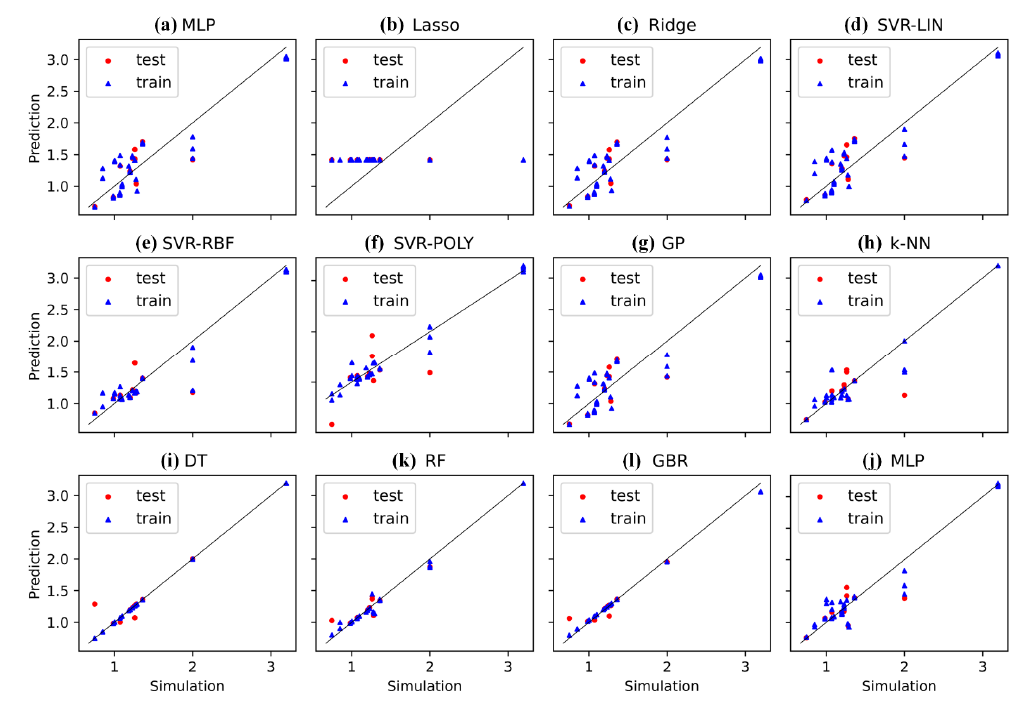
Figure 8. Simulation versus predicted values for shear viscosity in Poiseuille flow model of the LJ fluid, being the output of 12 different algorithms ( a – l ). Data points include both training and test data. The 45° identity line denotes the perfect match.